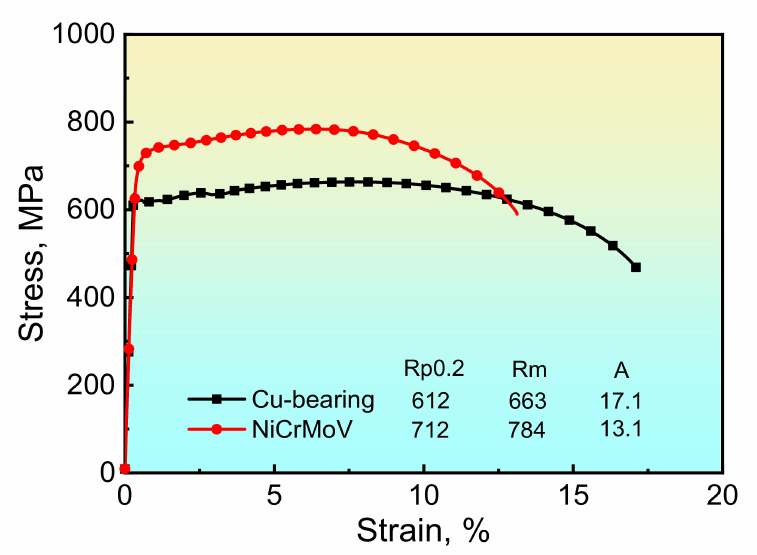
Figure 2. Stress–strain curves of as-tempered samples tensile tested at room temperature.